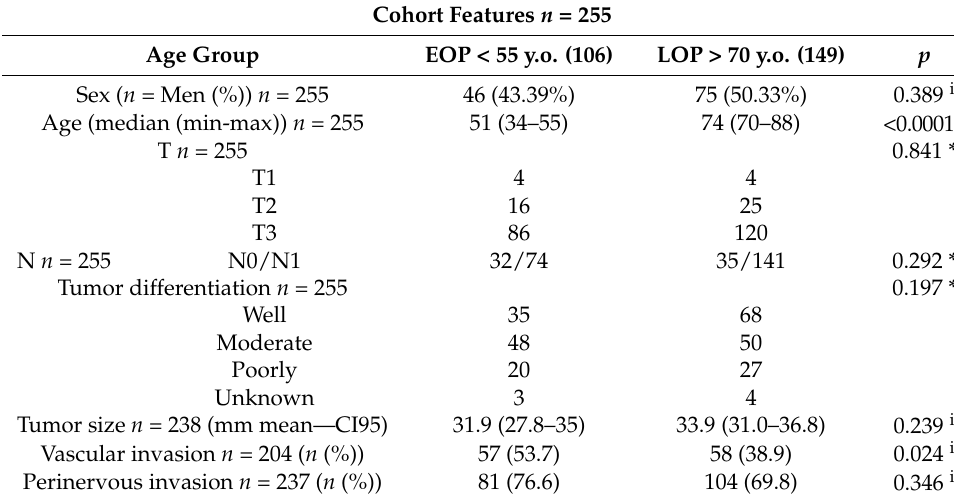
Table 1. Clinical features of the multi-centric cohort of this